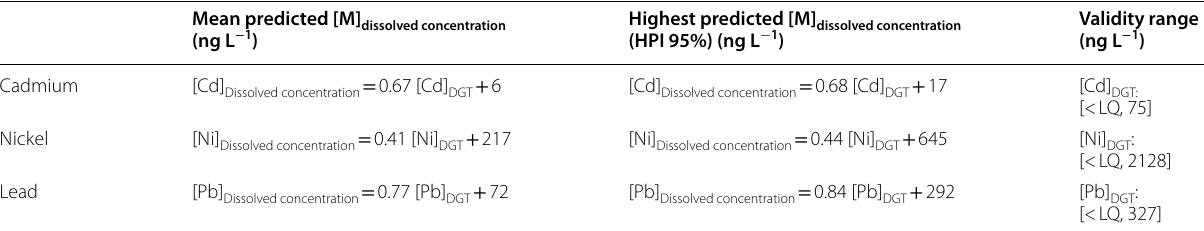
Table 5 Application of Eq. (2) for predicting Cd, Ni and Pb dissolved concentrations from DGT results